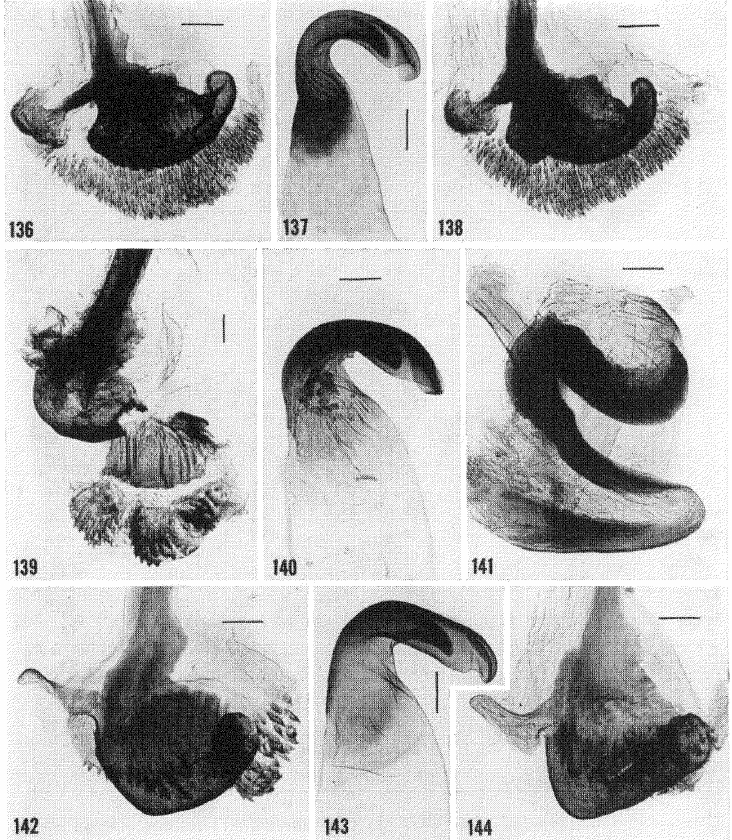
Figs. 136-144. 136-138. (12 MCZ). Monastria biguttata. Brazil. 139- 141. (6 MCZ). Monachoda burmeisteri. (from specimen shown in Fig. 124). The ventral surface of L2d (Fig. 139) was cut away and pulled down- ward to show the preputial spines. 142-144. (2 LEM). Monachoda grossa. 143-144. (21 BMNH). [onachoda grossa. (from specimen shown in Fig. 125). (scale 0.3